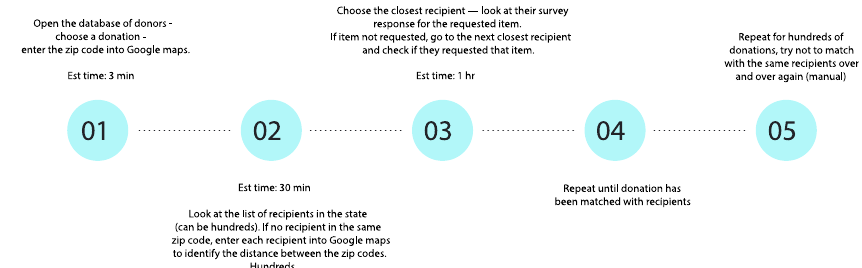
Fig. 2 Manual matching process description. A manual match process was limited by volunteer